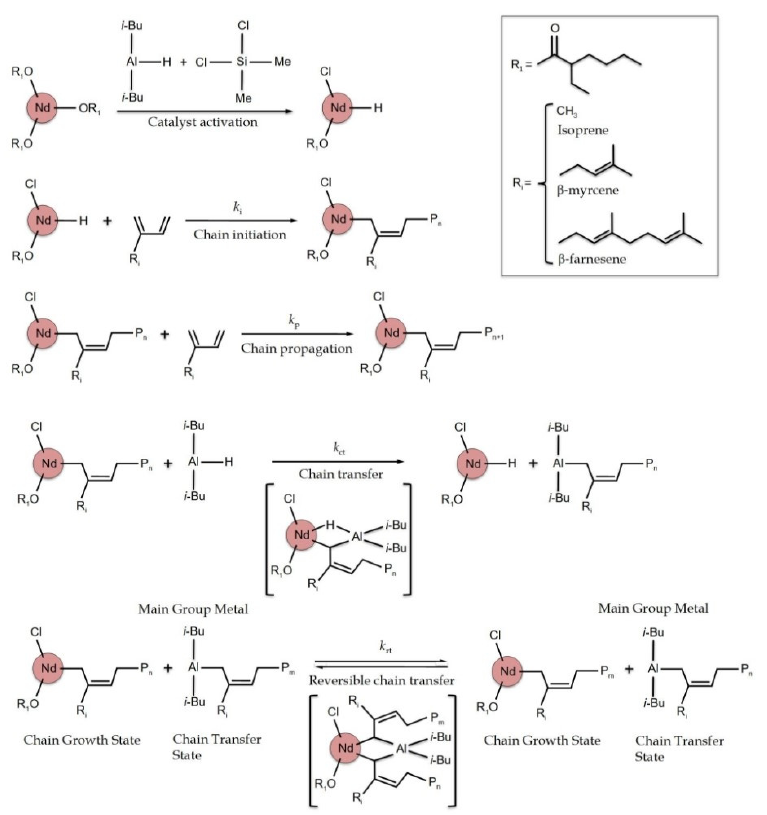
Figure 1. Reversible coordinative chain transfer polymerization mechanism applied for 1,3-diene initiated by an NdV 3 /Al( i -Bu) 2 H/Me 2 SiCl 2 catalyst system. Adapted from references [29,30,42,43].